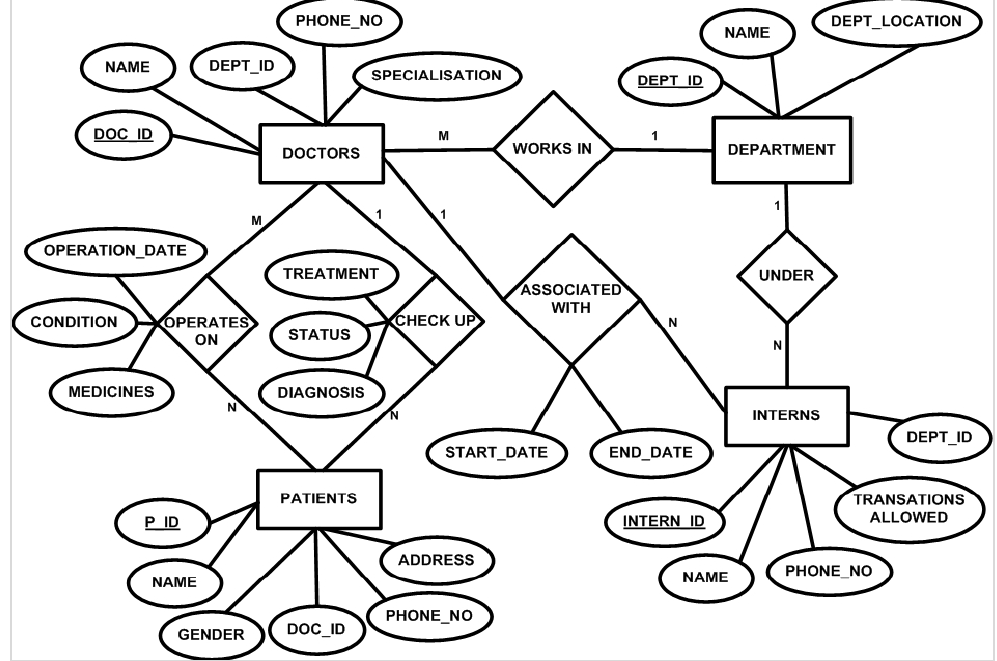
Figure 6. ER-Diagram for Hospital e-Record Management